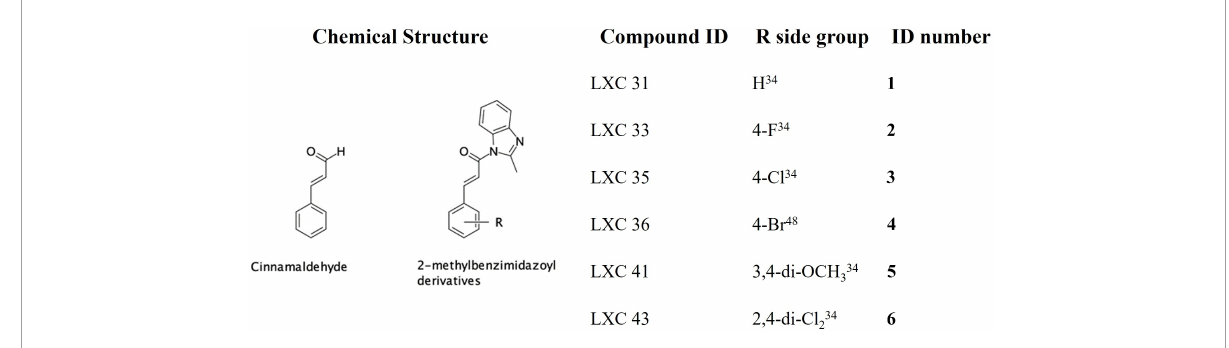
FIGURE1 Chemical structures of cinnamaldehyde and